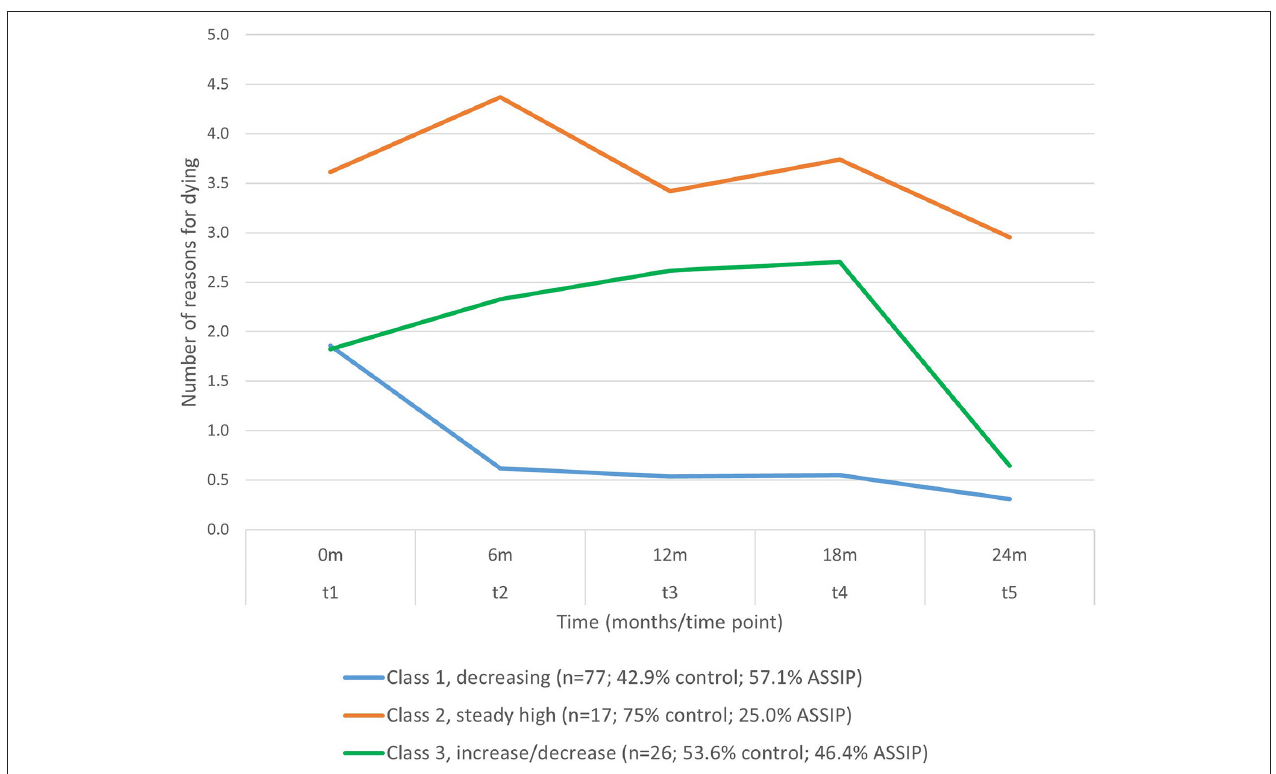
FIGURE 2 | Latent trajectories of reasons for dying from t1 to t5.